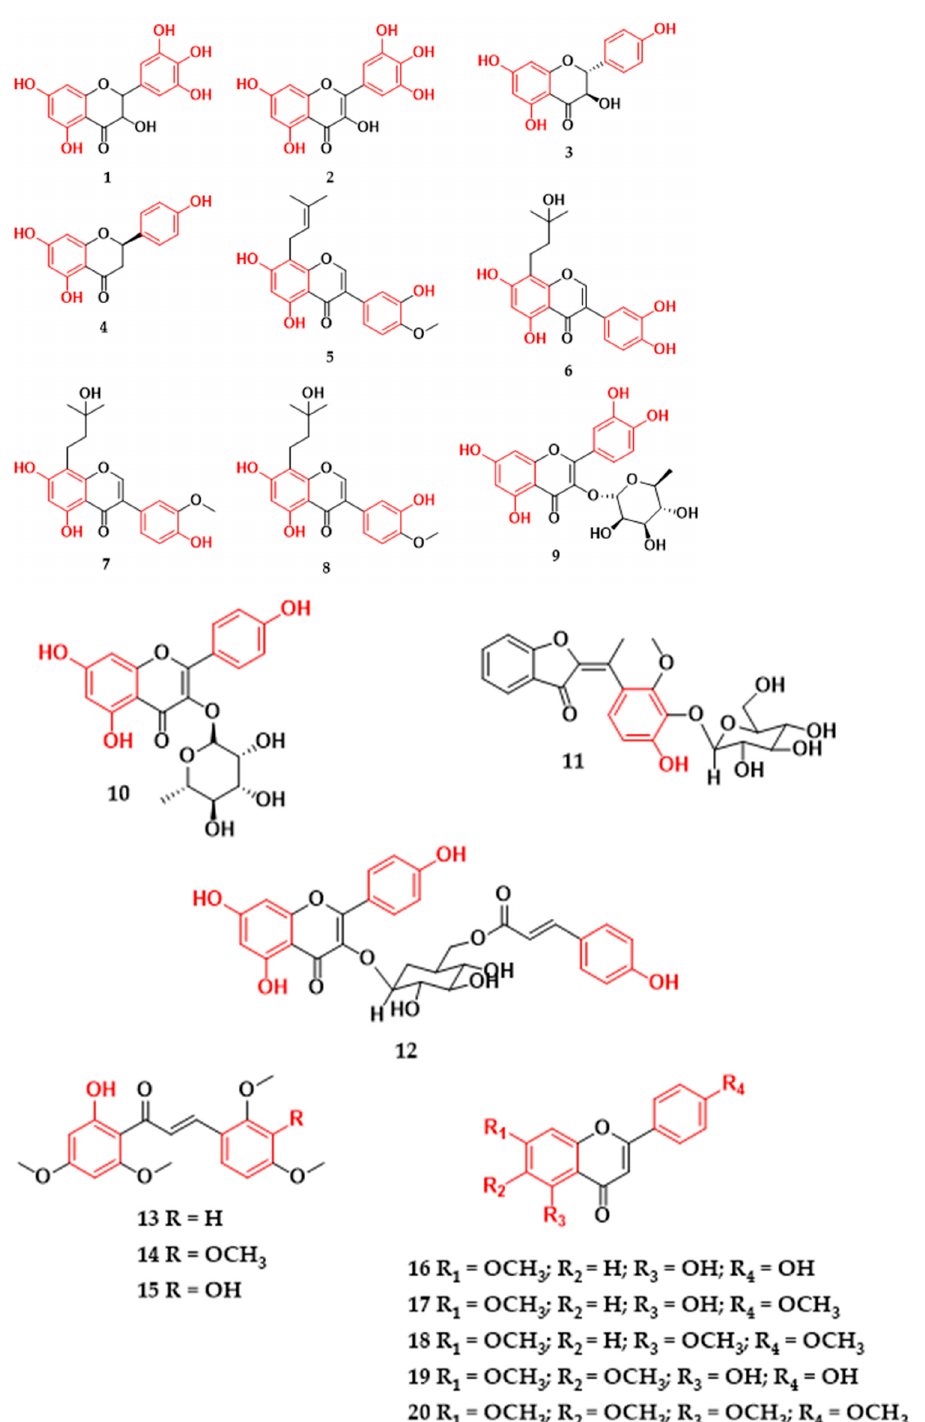
Figure 3. Flavonoids with antibacterial activity isolated from plants in Brazil. Ampelopsin ( 1 ), my- ricetin ( 2 ) , dihydrokaempferol ( 3 ) , (+)-(2R)-naringenin ( 4 ), 3,7,3 ′ -trihydroxy-4 ′ -methoxy-8-prenyli- soflavone ( 5 ), 8-(3-hydroxy-3-methylbutyl)-5,7,3 ′ ,4 ′ -tetrahydroxyisoflavone ( 6 ), 8-(3-hydroxy-3 - methylbutyl)-5,7,4 ′ -trihydroxy-3 ′ -methoxyisoflavone ( 7 ), 8-(3-hydroxy-3-methylbutyl)-5,7,3 ′ -trihy- droxy-4 ′ -methoxyisoflavone ( 8 ) , 3- O - α -L-rhamnopyranosylquercetin ( 9 ), 3- O - α -L-rhamnopyra- nosylkaempferol ( 10 ), ( E )-3 ′ - O - β - D -glucopyranosyl-4,5,6,4 ′ -tetrahydroxy-7,2 ′ -dimethoxyaurone ( 11 ), tiliroside ( 12 ), 2 ′ -hydroxy-4,4 ′ ,6 ′ -trimethoxychalcone ( 13 ), 2 ′ -hydroxy-3,4,4 ′ ,6 ′ -tetramethoxy- chalcone ( 14 ), 3,2 ′ -dihydroxy-4,4 ′ ,6 ′ -trimethoxychalcone ( 15 ), genkwanin ( 16 ), 7,4 ′ -dimethylapig- enin ( 17 ), trimethylapigenin ( 18 ), cirsimaritin ( 19 ), tetramethylscutellarein ( 20 ). In addition, it is suggested that the increase in antibacterial activity against S. aureus strains in flavonoids is related to the hydroxylation of carbons at positions C-5, C-7, C-3 ′ , and C4 ′ [61], which may explain the high inhibitory value for the molecules. The struc- tures of flavonoids ( 1 ) and ( 2 ) show the same substitution patterns, with hydroxyl groups on carbons C-3, C-5, C-7, C-3 ′ , C-4 ′ , and C-5 ′ , differing only in the unsaturation of the C ring. In work carried out relating the structure and activity of several flavonoids to the inhibition of Escherichia coli , the results showed more efficient inhibitory values in the fla- vonoids of the flavonol class [10]. Furthermore, some studies indicate that hydroxyl groups at the C-3 position are important for antibacterial activity and contribute to de- creasing the cell membrane fluidity of E. coli bacteria, which may be one of the direct in- hibitory mechanisms of flavonoids. In addition, it was observed that the hydrophobicity and electronic properties of flavonoids can determine their antibacterial activity against E. coli [10,52]. Therefore, although there may be a greater propensity for flavonoids to inactivate Gram-positive bacteria, some molecules may be equally effective in inactivating Gram-negative bacteria, ensuring a characteristic of flavonoids as multitarget compounds. Regarding compounds with action on Gram-positive bacteria, the flavonoids dihy- droxykaempferol ( 3 ) and naringenin ( 4 ) (Figure 3), isolated from the stem of Maurutia flex- uosa species, were shown to be active against methicillin-susceptible Staphylococcus aureus